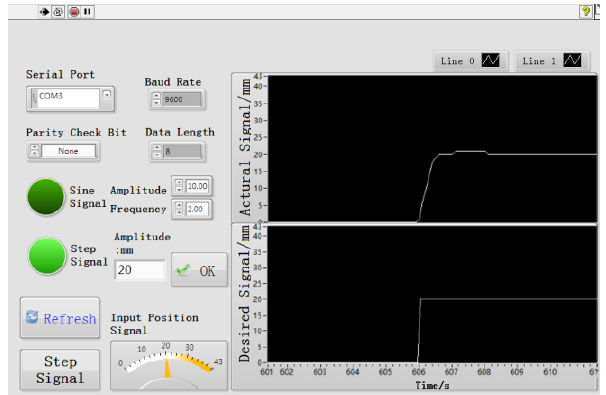
Figure 11. Time response of the hydraulic cylinder position in the tracking of the desired step signal.